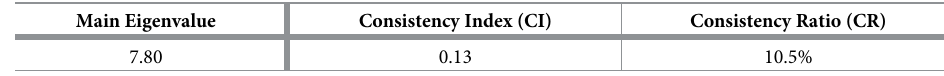
Table 4. Consistency calculation.